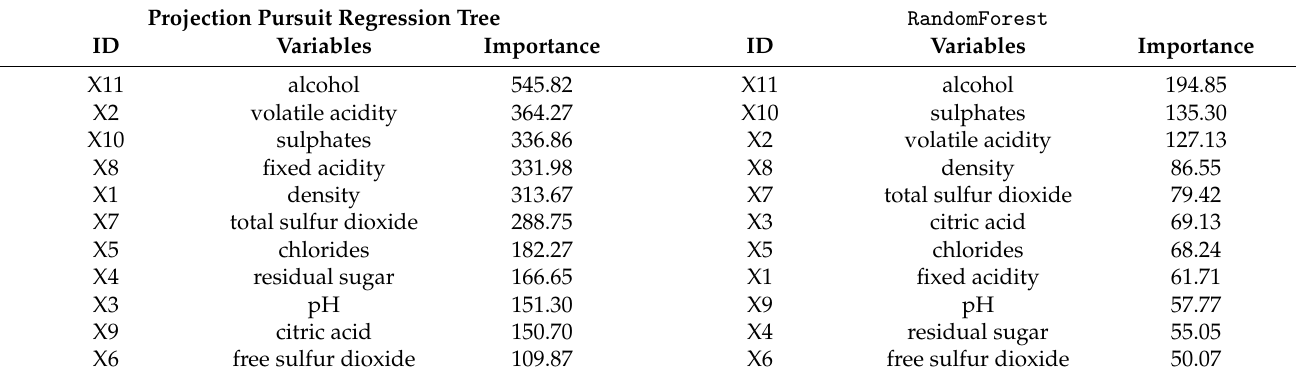
Table 6. Importance measures of the red wine